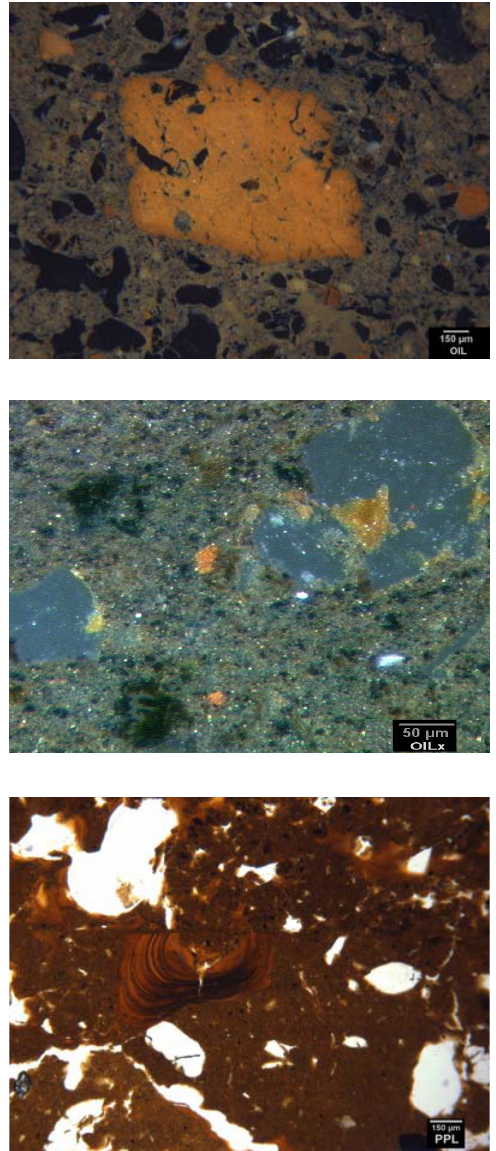
Figure 5. Microphotographs of selected features in terras pretas (row 1 and 2) and terras mulatas (row 3). Top left: microscopic fragment of fish bone, the fluorescent colour indicates high retention of phosphorus. Top right: microscopic fragments of pottery and rubified clay, the latter probably originating in clay ovens. Middle row: microscopic fragments of charcoal. Note that fragments can be resolved optically: the darker colours on the right-hand side microphotograph are likely to reflect the formation of manganese oxides. Bottom left: important quantities of microscopic charcoal but absence of bone or pottery fragments in the A horizon of terra mulata . Bottom right: truncated illuvial clays show lack of mixing between the terra mulata A horizon and the charcoal-devoid limpid clays of the B